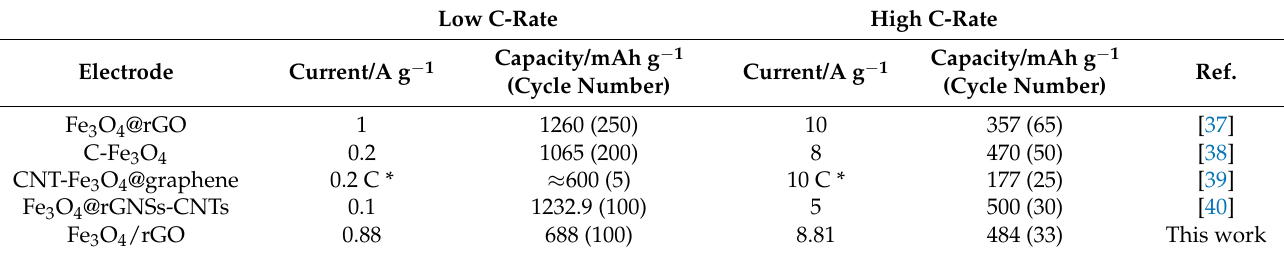
Table 2. Comparison of low- and high-C-rate performances of Fe 3 O 4 -based composite anodes. Low C-Rate High